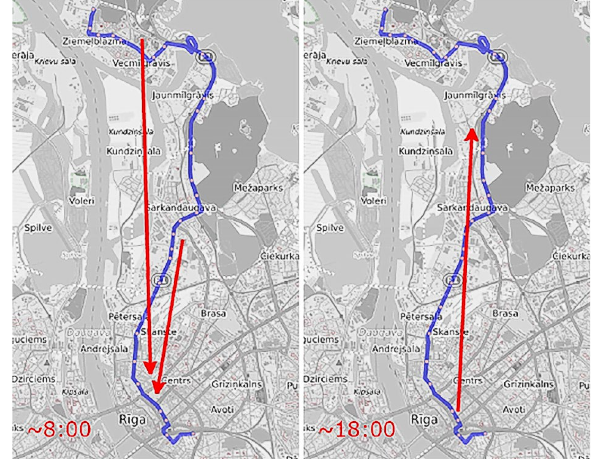
Figure 2. Typical mobility patterns for a selected bus